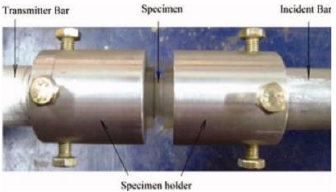
Fig. 1. Adhesive bonded tubular specimen. Fig. 2. Specimen gripped by hexagonal holders.